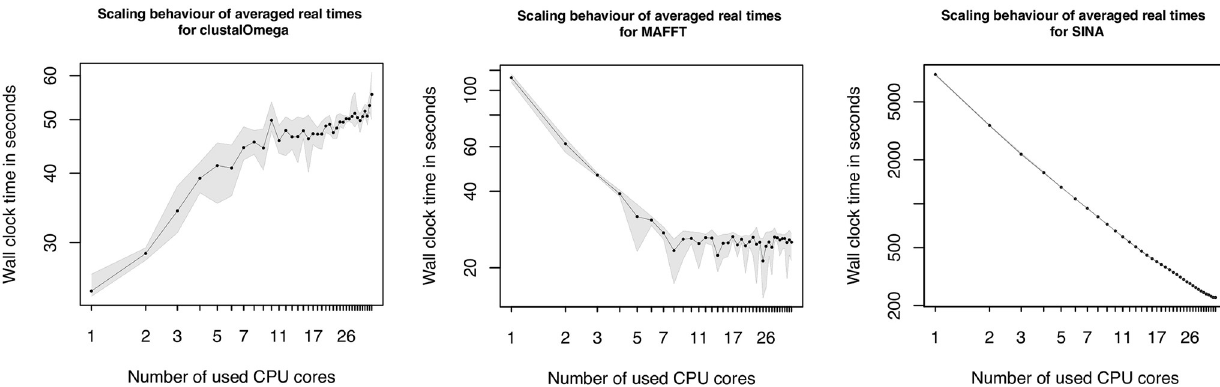
Fig 5. Scaling plots 9—11. The graphs illustrate the scaling behavior of Clustal Omega (left), MAFFT (middle) and SINA (right) using the long dataset. The x-axes values are in the range of 1 to 36 and represent the number of used cores. The y-axes show averaged wall-time values in seconds. The ranges of the y- axes differs, depending on the tool. Both axes are logarithmic, to make a linear behavior visible. To indicate the minimum and maximum wall-time values of the five executed runs, a gray area has been inserted, whose boundaries represent the lowest and highest measured values.